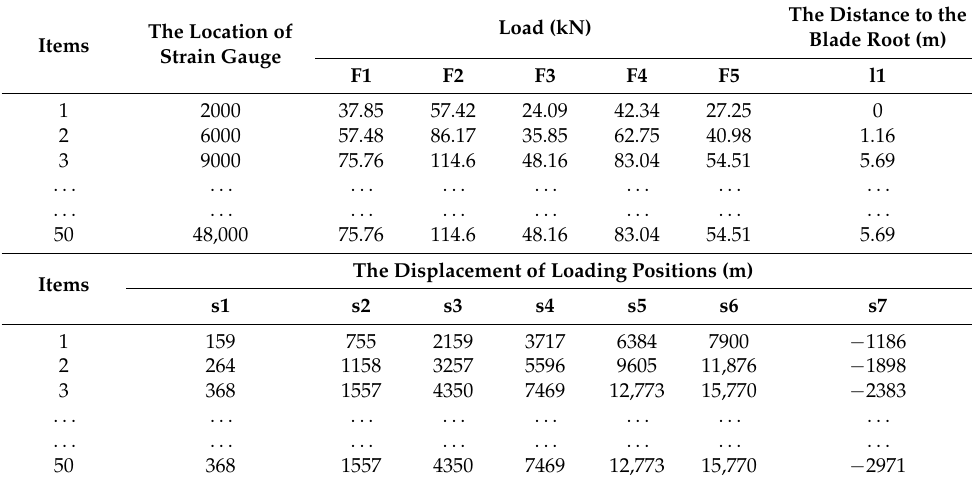
Table 3. The training samples of the GA-BPNN.